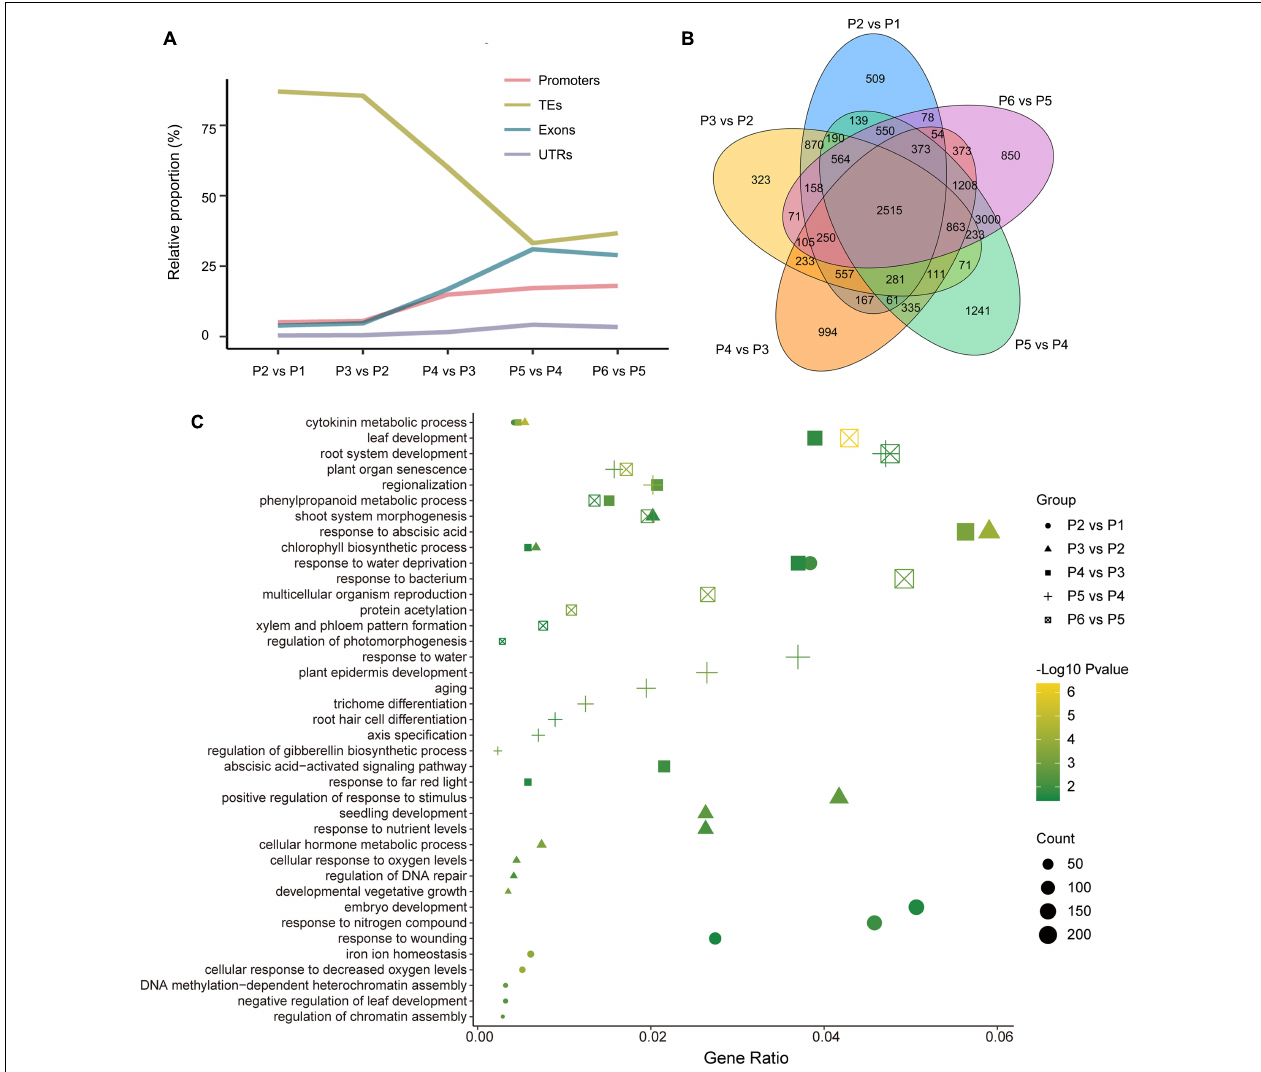
FIGURE 5 | Overview of genome-wide DMR-associated genes (DMGs) during the tissue culture process of F. nilgerrensis . (A) Dynamic distribution of DMGs in each gene component. (B) Venn diagram showing DMGs among the different stage. (C) Go enrichment in each comparison between adjacent stages.